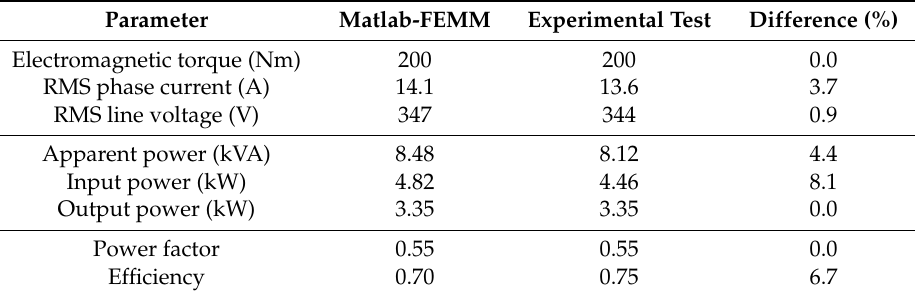
Table 5. Prototype results comparison.